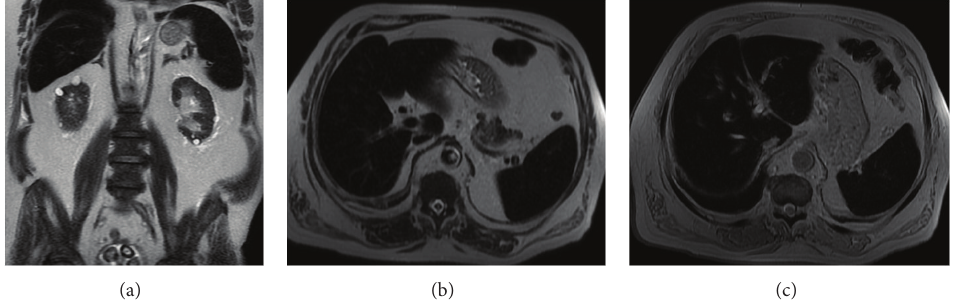
Figure 21: Paroxysmal nocturnal hemoglobinuria. Coronal (a) and axial (b) T2wi SSFSE and axial T2 ∗ (c) images. This patient with paroxysmal nocturnal hemoglobinuria shows diffuse diminished signal intensity of the liver and spleen on T2wi as a result of hemosiderin deposition. Notice the iron accumulation on the renal cortex